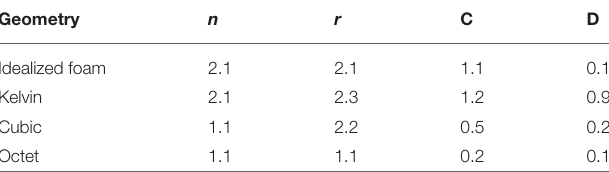
TABLE 2 | Scaling exponents and proportionality constants for power-law approximations of E lattice and G lattice for the four lattice geometries. Geometry n r C D Idealized foam